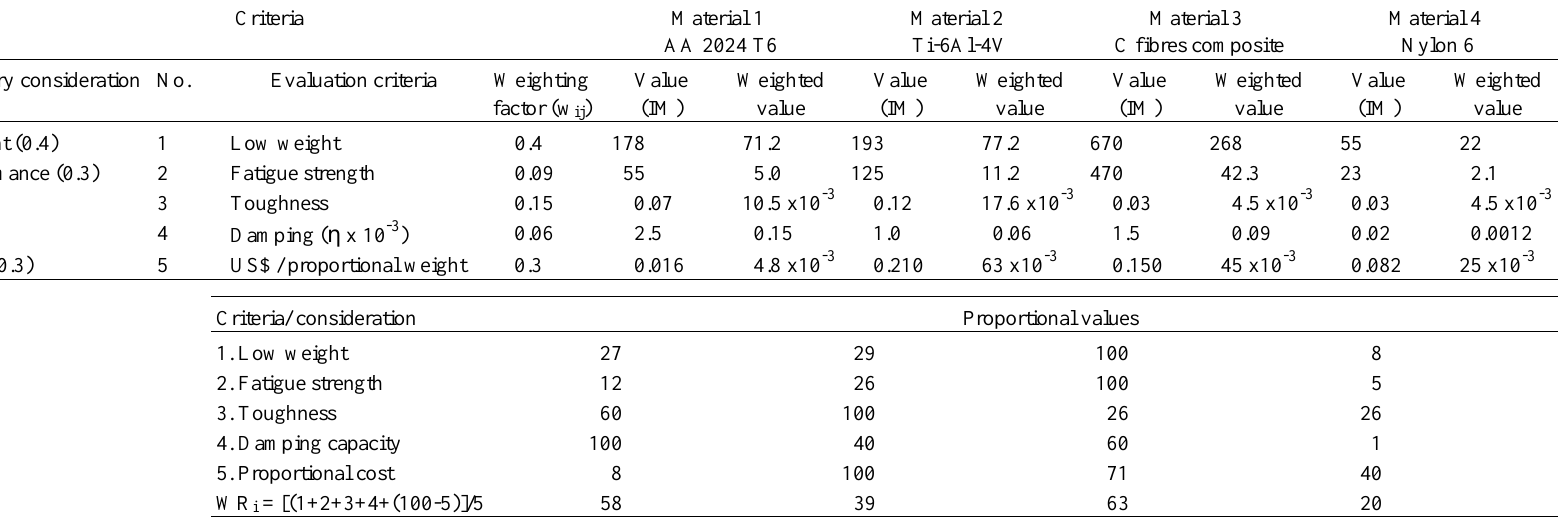
Table 4. Pahl and Beitz-based decision matrix for the centrifuge